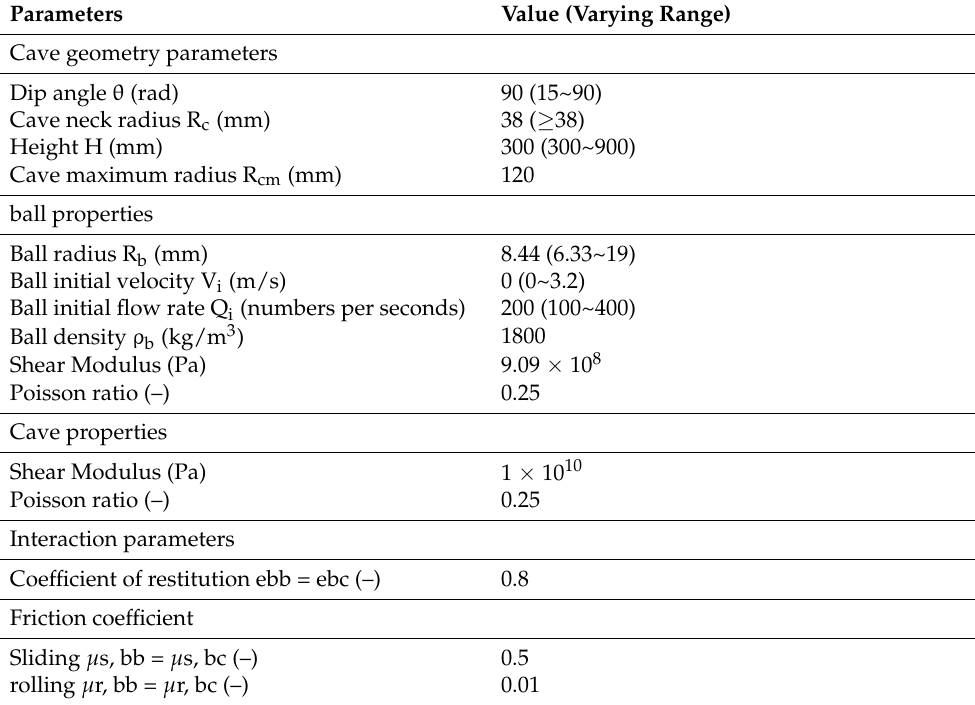
Table 2. Parameters used in the DEM